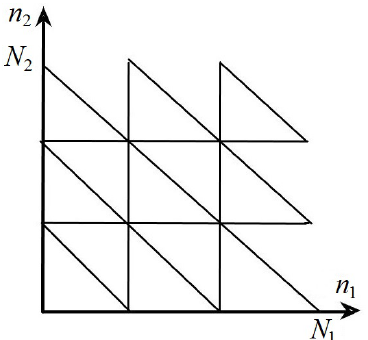
Figure 3. Undirected graph Γ representing network G with failures at critical levels N 1 , N 2 for numbers of customers in nodes